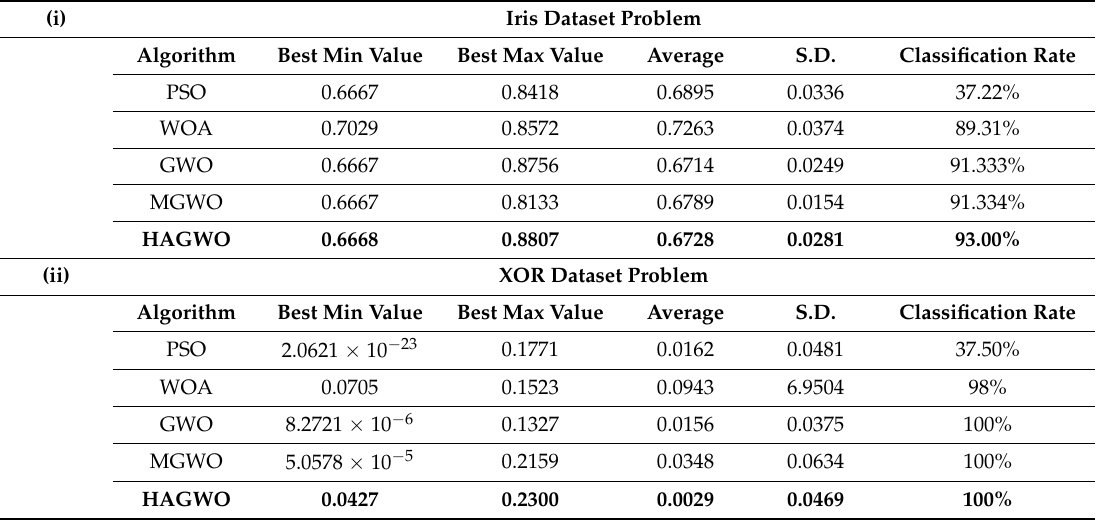
Table 10. Numerical and Statistical solutions of Bio-Medical